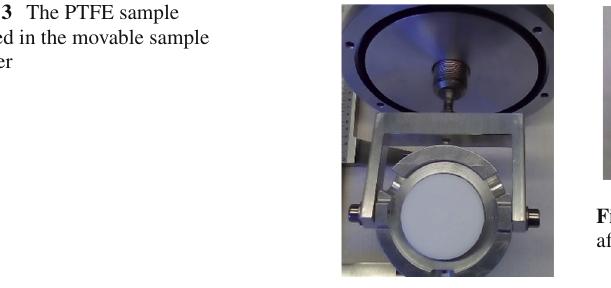
minutes at room temperature. Then, they were dried with a nitrogen gun. 4 Pictures of the acrylic samples are shown in Fig.